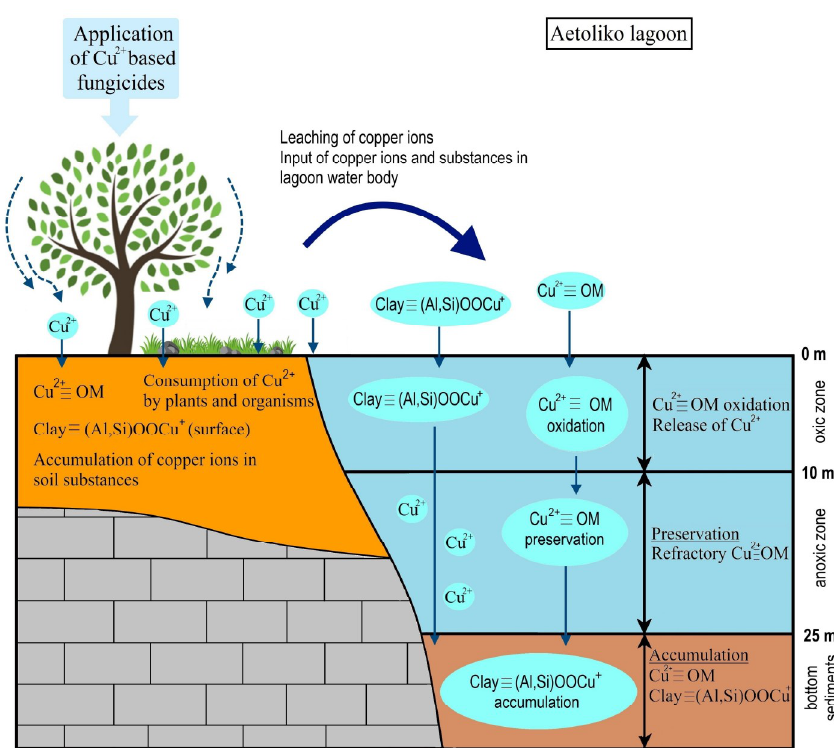
Figure 6. Schematic representation of the major geochemical processes of copper ions in the studied area.